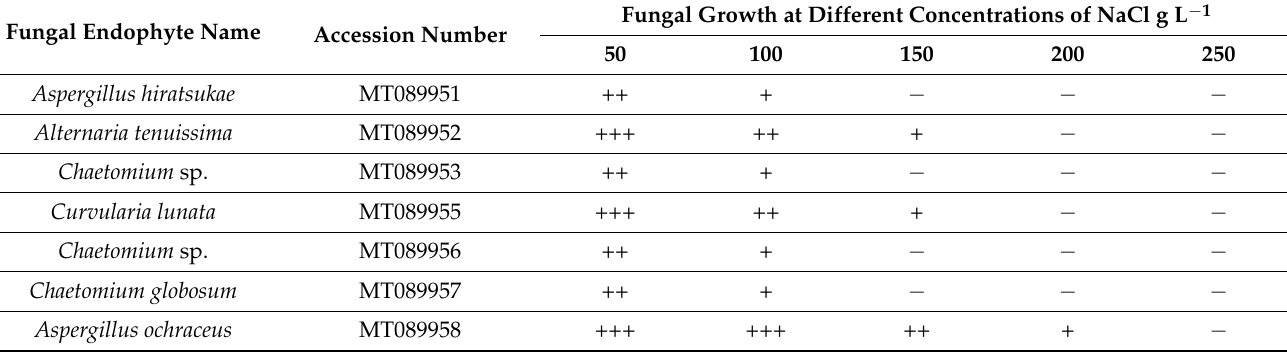
Table 1. Screening of salt-tolerant endophytic fungi.